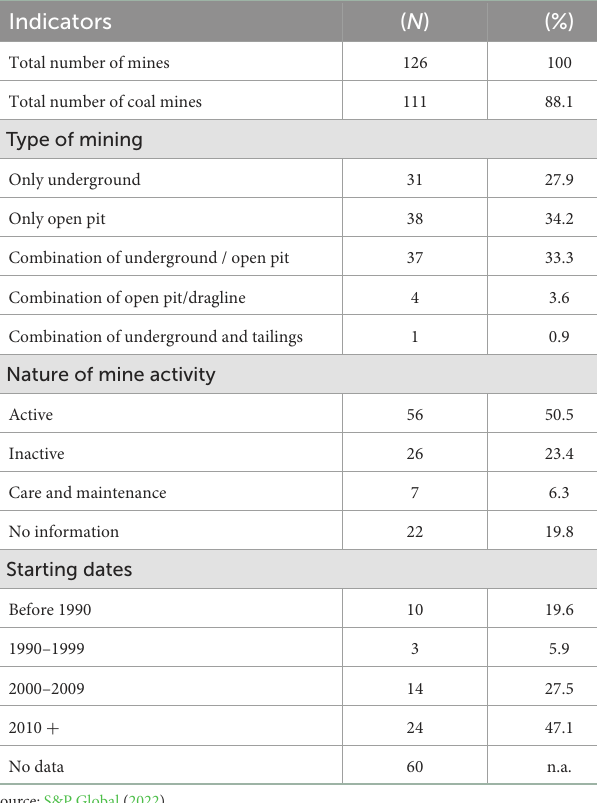
TABLE 2 An overview of the coal mining in